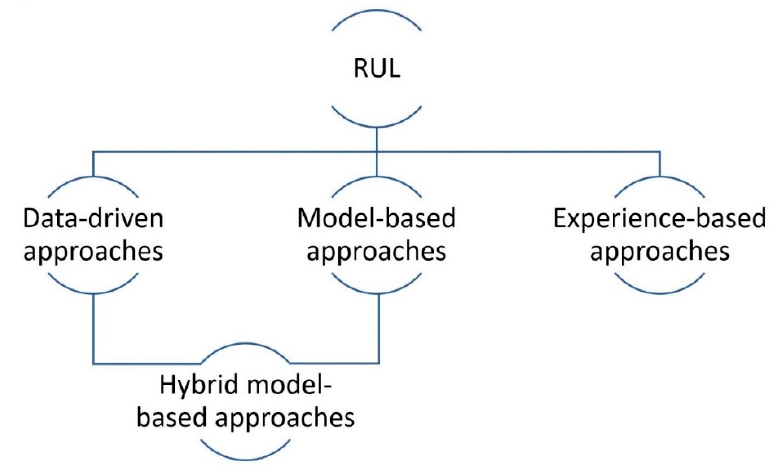
Figure 1. Remaining useful life (RUL) estimation models.